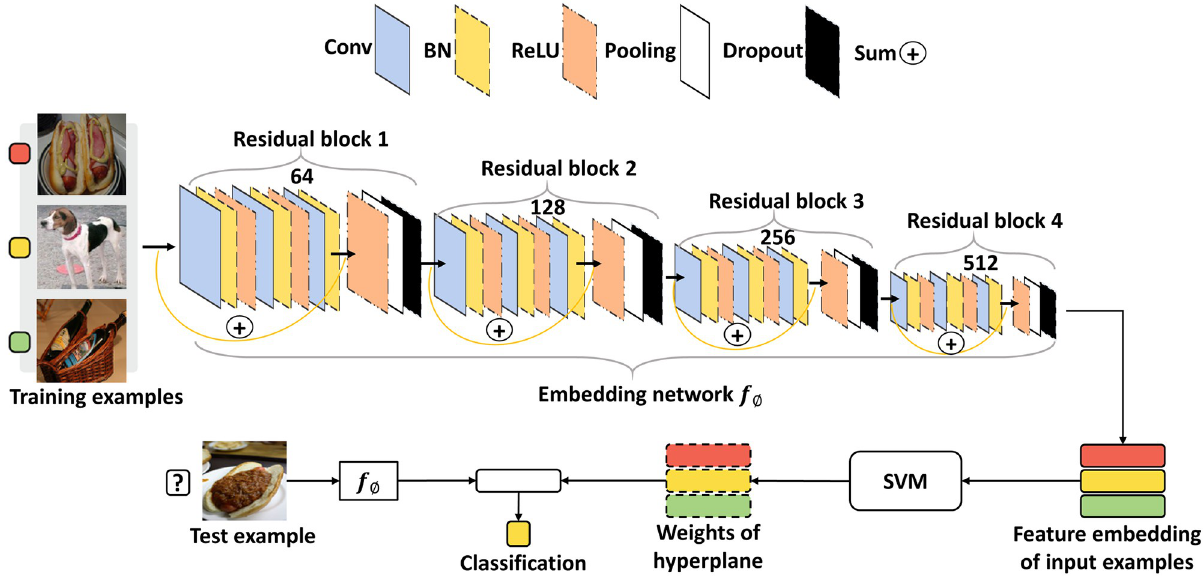
Fig 2. The detailed architecture of MetaOptNet. The goal of MetaOptNet is to adjust the parameters ϕ of the embedding network f tasks so that it can generalize well to new tasks. The numbers (e.g., 64, 128, 256, and 512) represent the number of convolutional filters used in each residual block. The sum operation sums up the input of a residual block to the output of the third BatchNorm layer in the corresponding residual block. The images of training and test samples are obtained from the miniImageNet dataset, which is publicly available on https://drive.google.com/file/d/ 1fJAK5WZTjerW7EWHHQAR9pRJVNg1T1Y7/view.